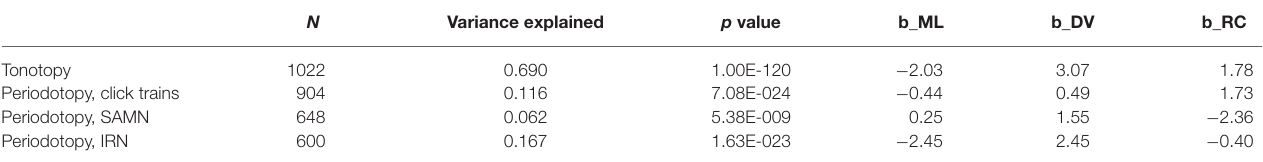
TABLE 1 | Comparison of regression analyses quantifying the tonotopy shown in Figure 4 and the periodotopies shown in Figure 7A. N Variance explained p value b_ML b_DV